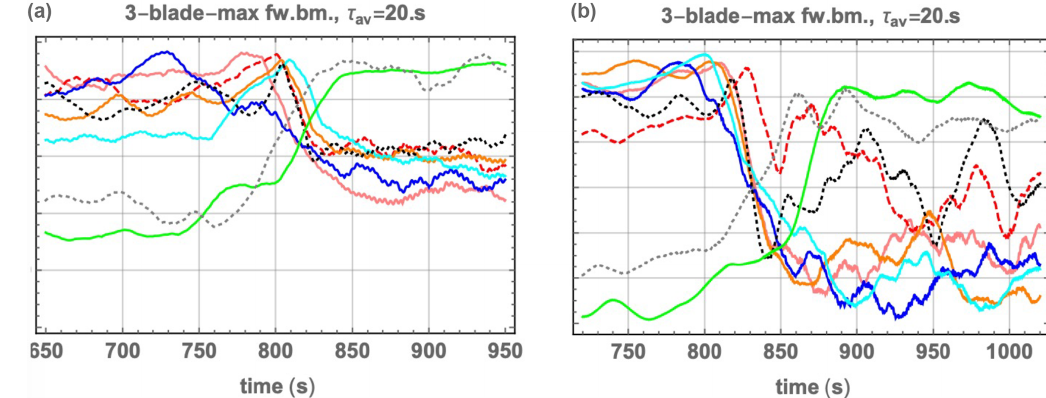
Figure 18. Maximum flap-wise blade-root bending moment M brfw over all three blades. (a) Stand-alone Flex5 simulations driven by con- strained Mann model (CMM). (b) Coupled LES outputs for first (upwind) turbine. Dimensional results shown on same axes; values hidden to protect proprietary information. Color/case legend as in Figs. 11–12, 14–17, 19, and